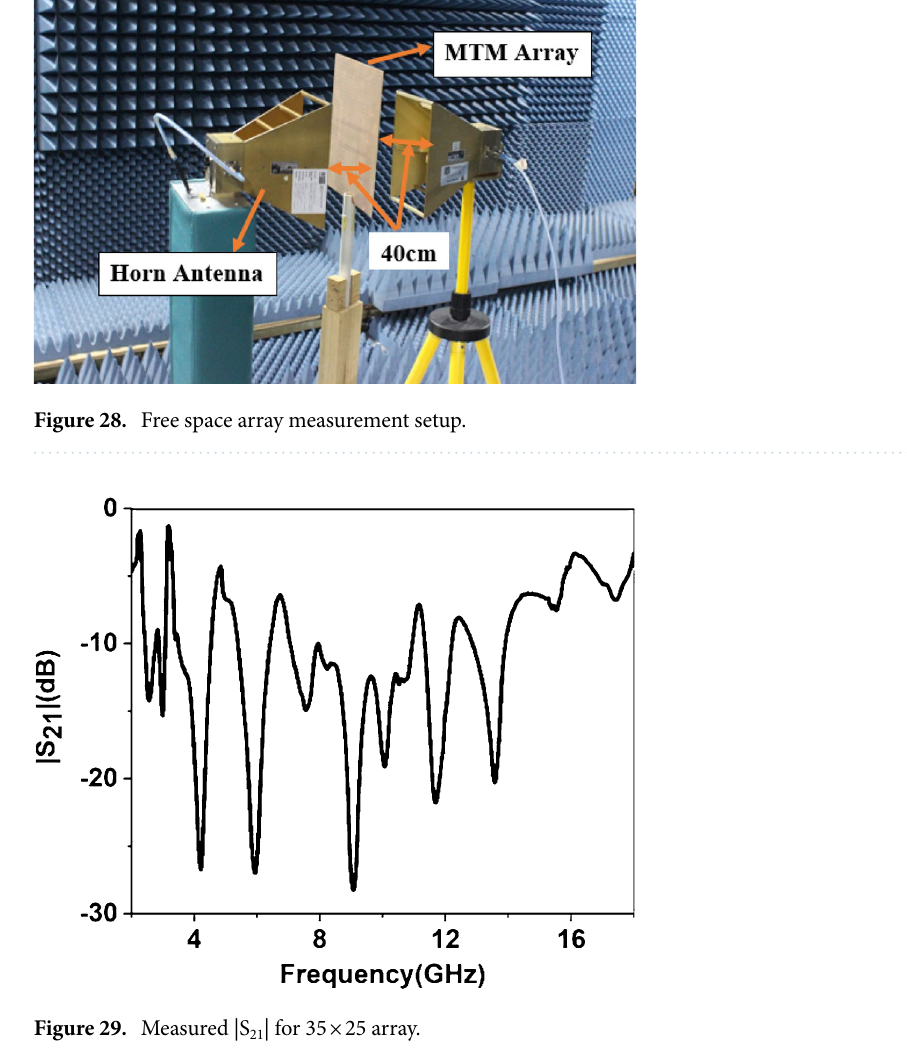
Ref Year Electrical dimension (λ × λ) No. of resonances Covering